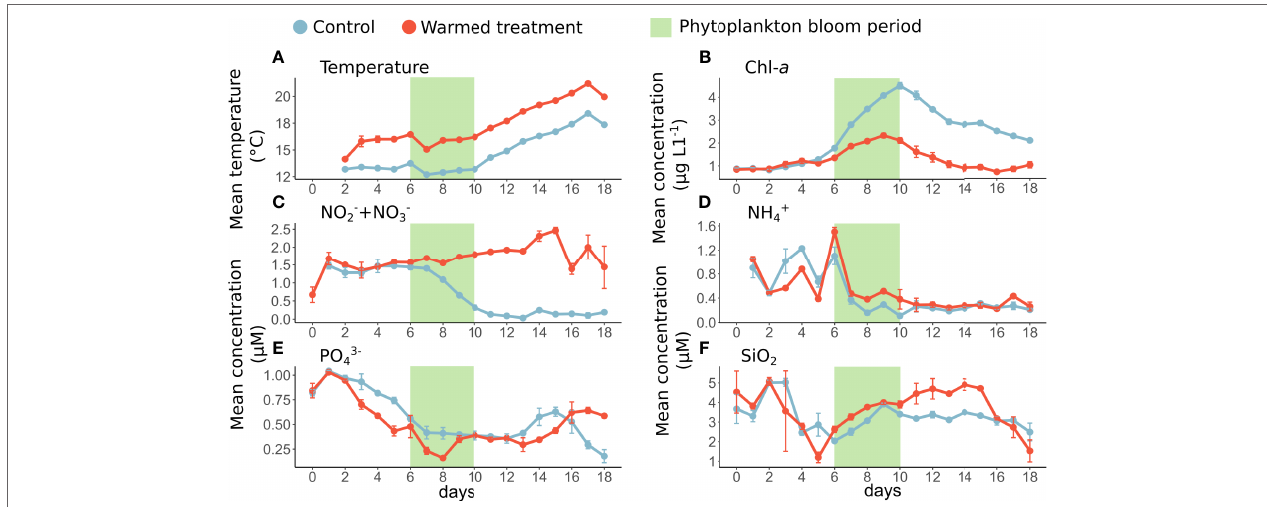
FIGURE 1 | Daily mean temperature (A) and concentrations of Chl- a (B) , nitrite + nitrate (C) , ammonium (D) , orthophosphate (E) and silicate (F) in the control (blue) and warmed treatments (red). The error bars represent the range of the observations, and the green rectangle represents the phytoplankton bloom period. Temperature measurements on days 0 and 1 were not available due to a technical issue as well as NO 2- +NO 3- data on day 0 in the control treatment and NH 4+ data on day 0 in both